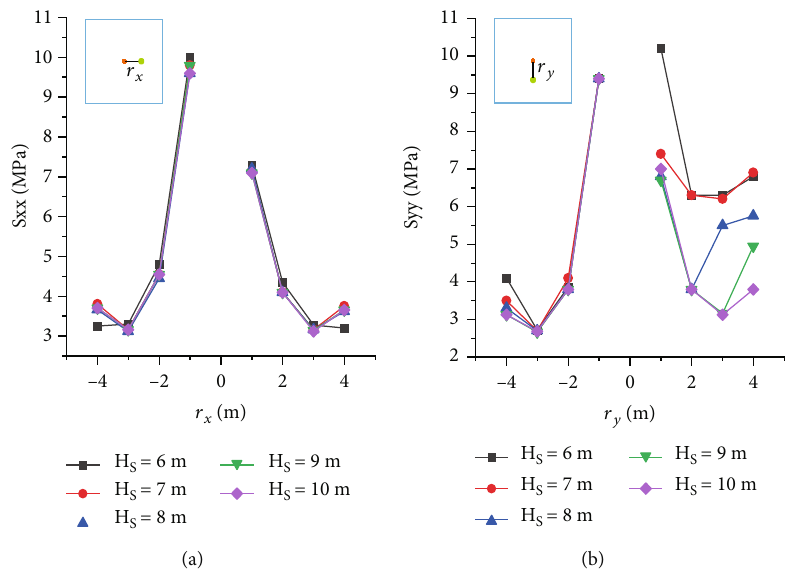
Figure 14: Variation curve of peak stress with r